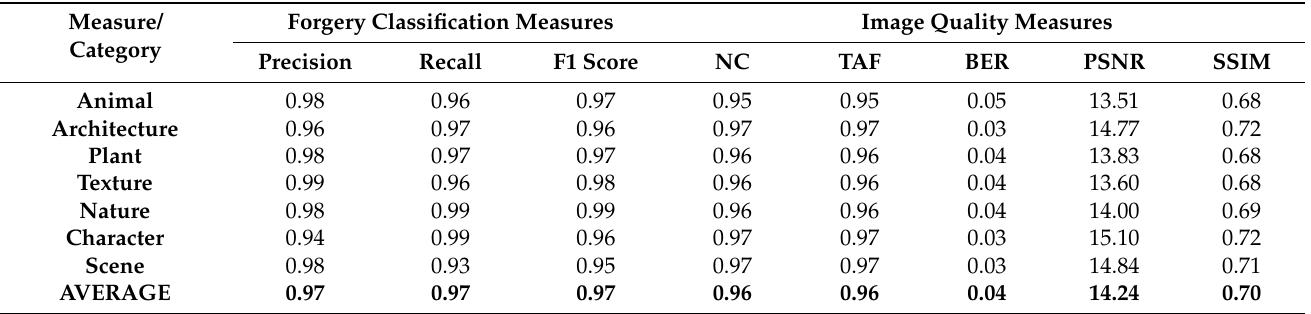
Table 1. Forgery classification and image quality measure values for the first group of